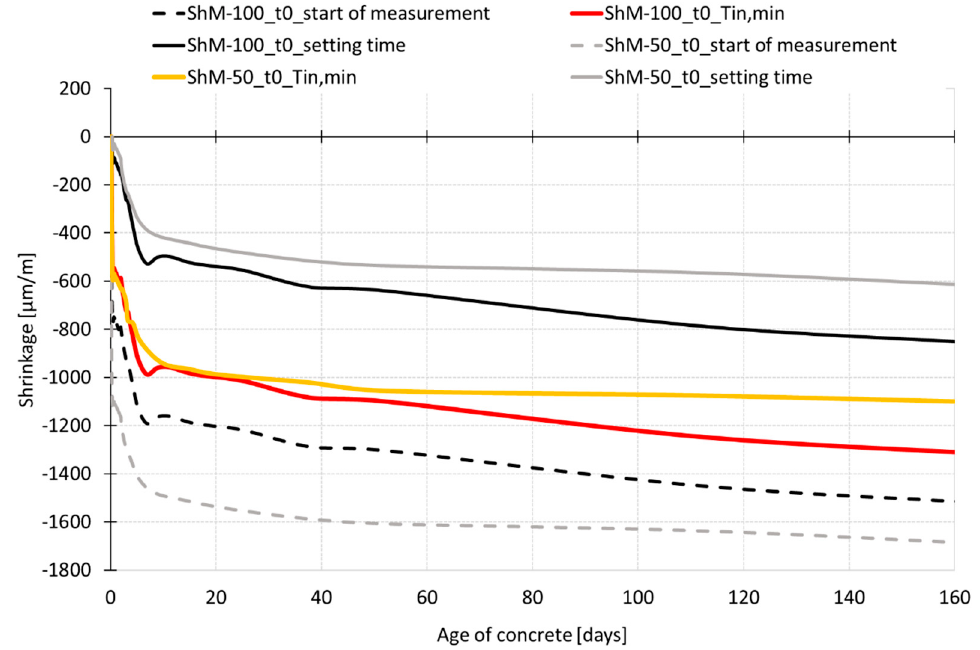
ff ect of specimens’ size: zeroed at di ff erent time t Figure 14. Effect of specimens’ size: zeroed at different time t 0 . Figure 14. E